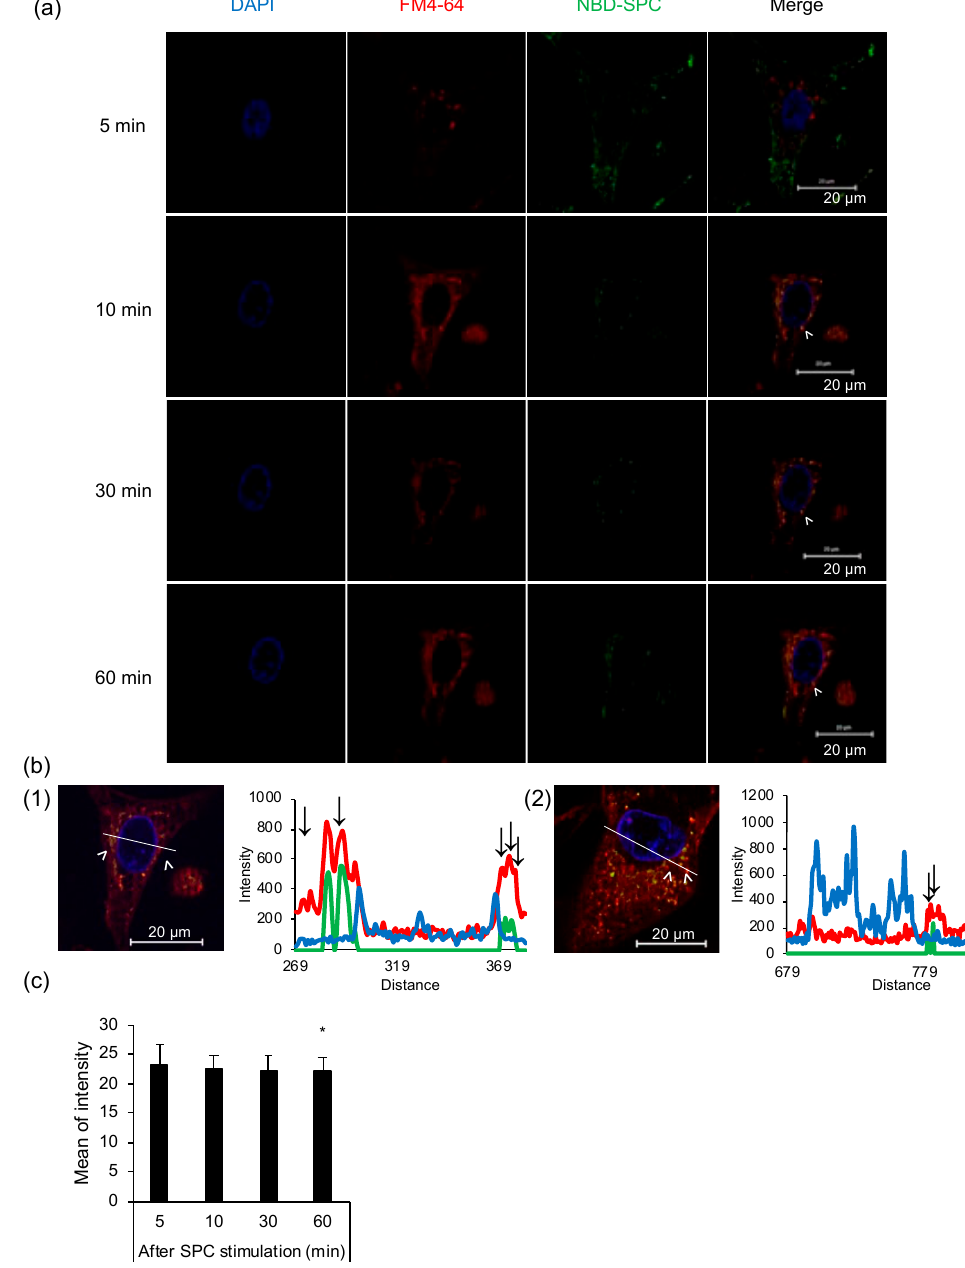
Figure 4. Cellular uptake of sphingosylphosphorylcholine (SPC). ( a ) Cellular uptake of nitrobenzoxadiazole (NBD)-SPC via endocytosis. Representative images indicate the localization of endosomes (red) and NBD-SPC (green) in the nucleus (blue). Top to bottom row: cells visualized 5, 10, 30, and 60 min after SPC stimulation. ( b ) The histogram shows the fluorescence profile for the enlarged image, illustrating the fluorescence intensity in each channel for endosomes (red line), NBD-SPC (green line), and the nucleus (blue line) against the distance along the line indicated on the micrograph. Arrows indicate co-localization of NBD-SPC and endosomes. SPC-stimulated human coronary artery smooth muscle cells (1) without fisetin and (2) with fisetin treatment. ( c ) Mean fluorescence intensity of cellular uptake of NBD-SPC after 5, 10, 30, and 60 min of SPC stimulation. Data are represented as mean ± standard deviation. * p < 0.05 vs. 5 min after SPC stimulation.